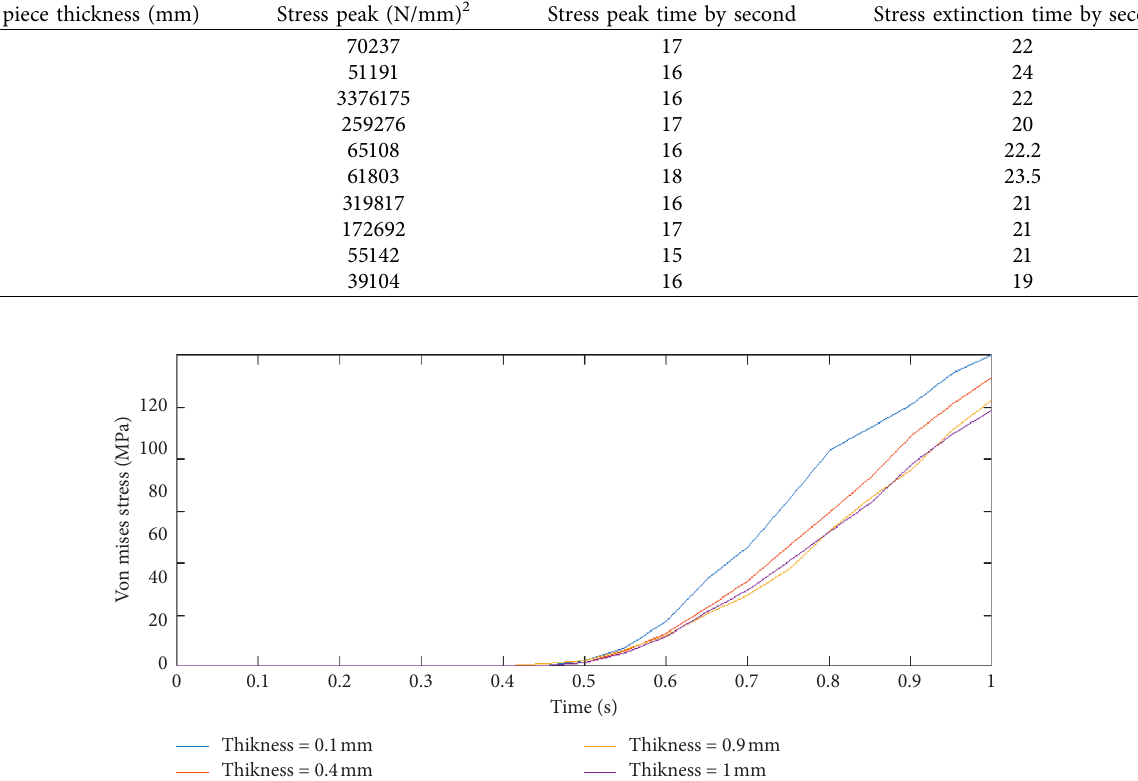
Figure 7: Stress evolution as function of time and thickness of the steel piece at an element of the lower